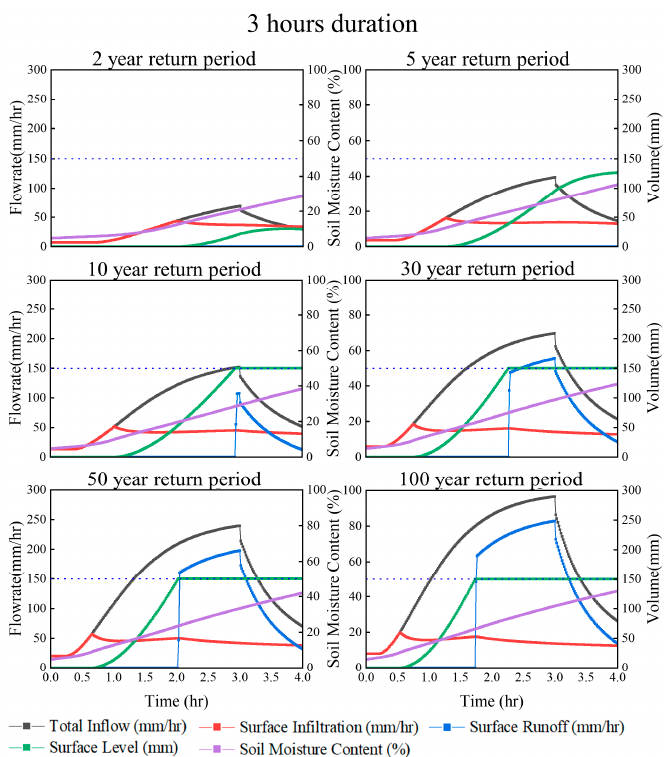
Figure 9. SWMM detailed reports on rain gardens in 3 h rainfall events.